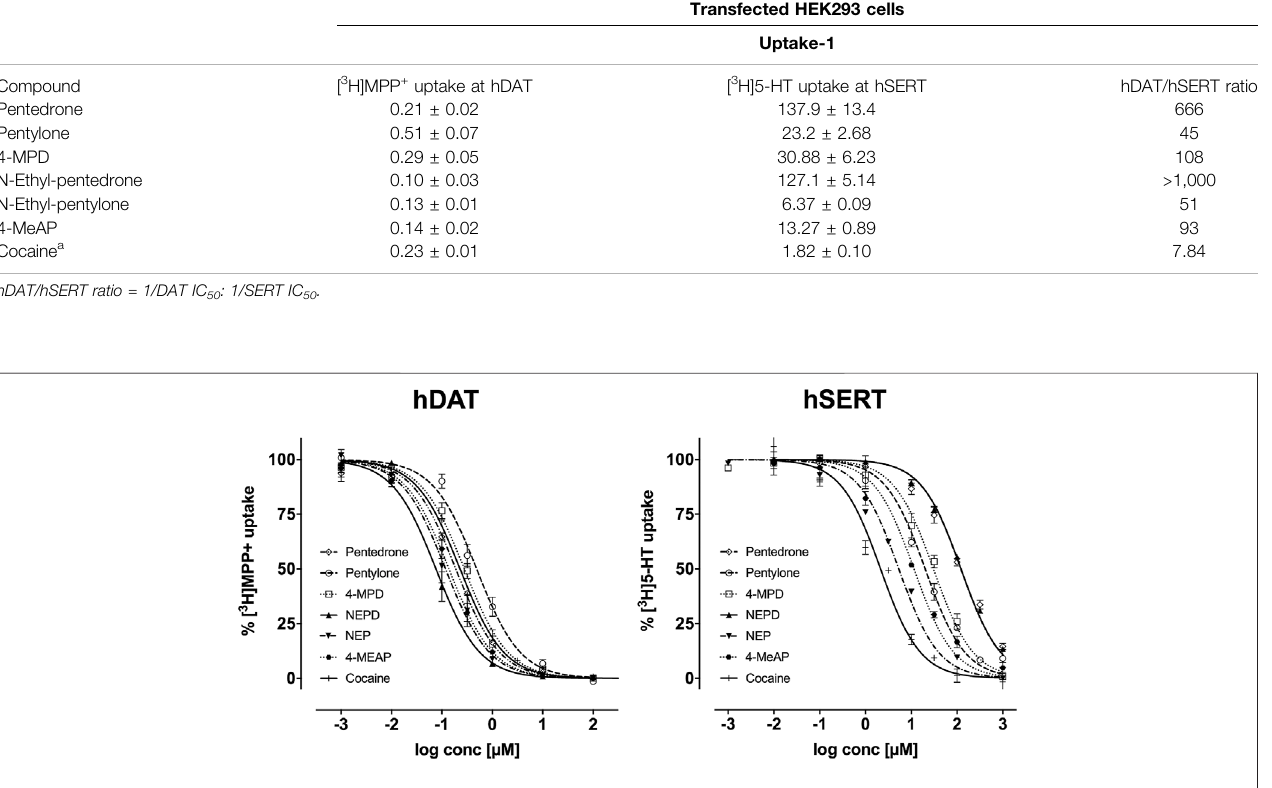
FIGURE 2 | Effects of pentedrone, pentylone, 4-MPD, NEPD, NEP, and 4-MeAP on [ 3 H]MPP + uptake inhibition at the DAT and [ 3 H]5-HT uptake inhibition at the SERT in transfected HEK293 cells. Data are expressed as a percentage of control uptake (mean ± SEM) of 3-4 independent experiments performed in triplicate.